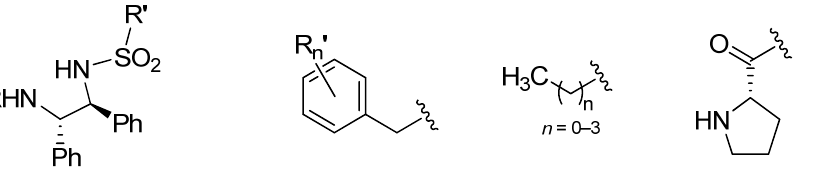
Figure 4. Examples of reported N'-alkylated diamine